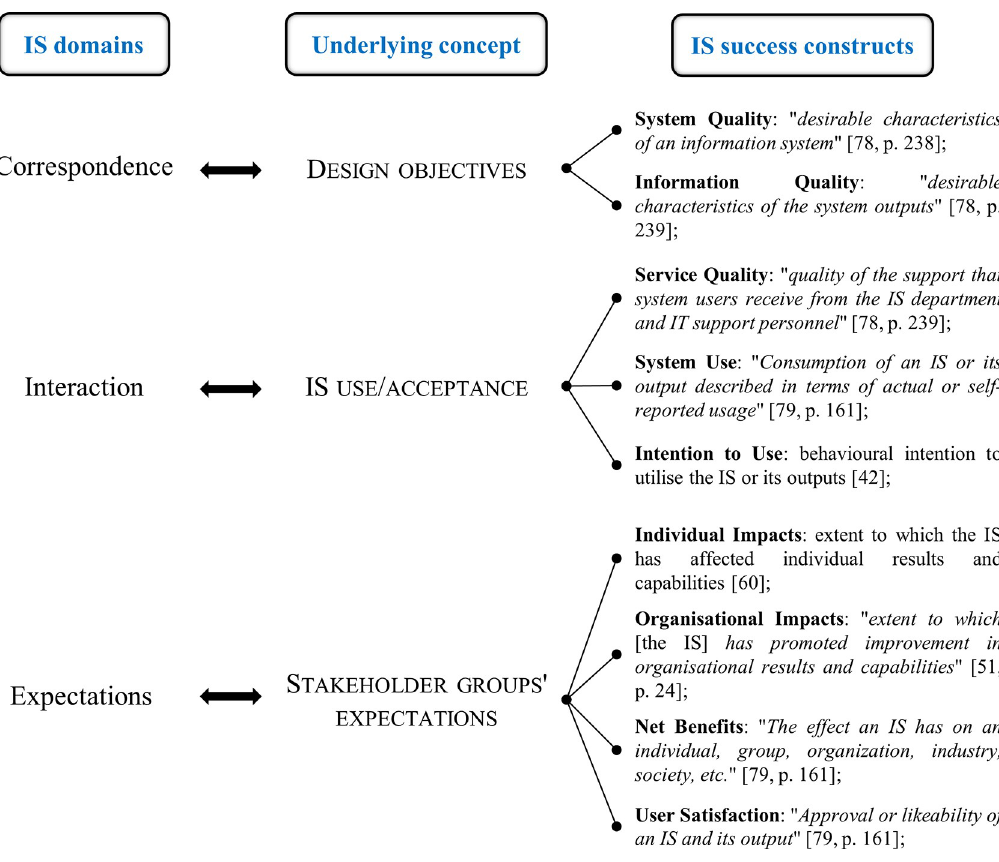
Fig 1. Association between IS domains and IS success